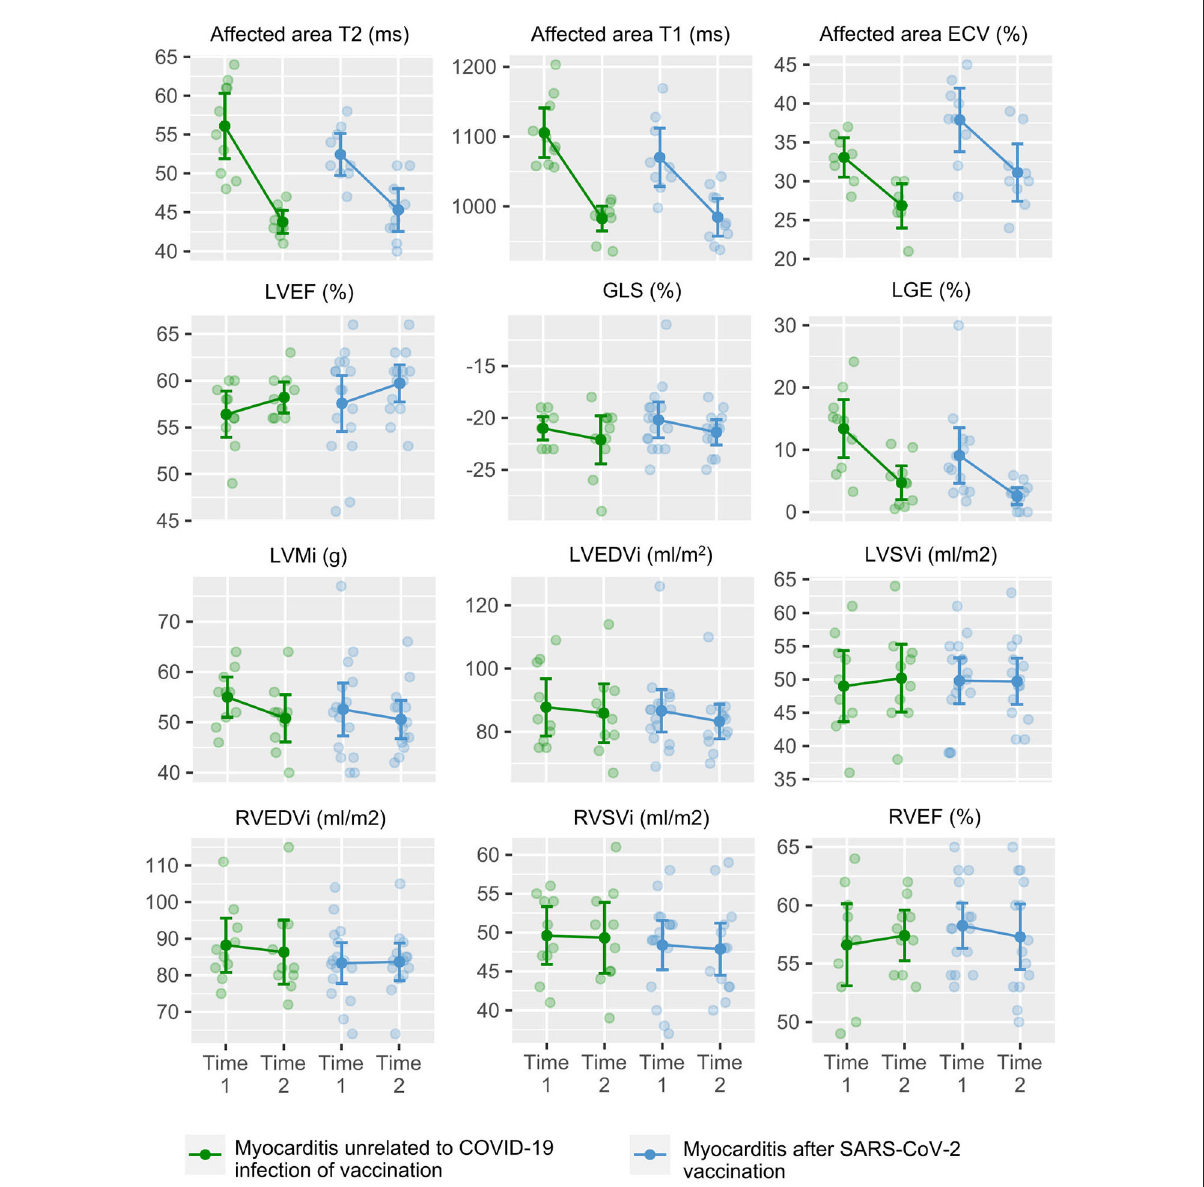
FIGURE4 CMR metrics of myocarditis patients after SARS-CoV-2 immunization and myocarditis patients unrelated to COVID-19 immunization or infection over the acute phase and follow-up scan. Graphs show the trajectory of CMR metrics between the acute (T1) and follow-up (T2) CMR scans in myocarditis patients after SARS-CoV-2 immunization (in blue) and myocarditis patients unrelated to COVID-19 infection or vaccination (in green). CMR, cardiac magnetic resonance; ECV, extracellular volume; EDVi, left ventricular end diastolic volume index; EF, ejection fraction; ESVi, end systolic volume index; GLS, global longitudinal strain; Mi, mass index; LGE, late gadolinium enhancement; LV, left ventricular; RV, right ventricular; SVi, left ventricular stroke volume